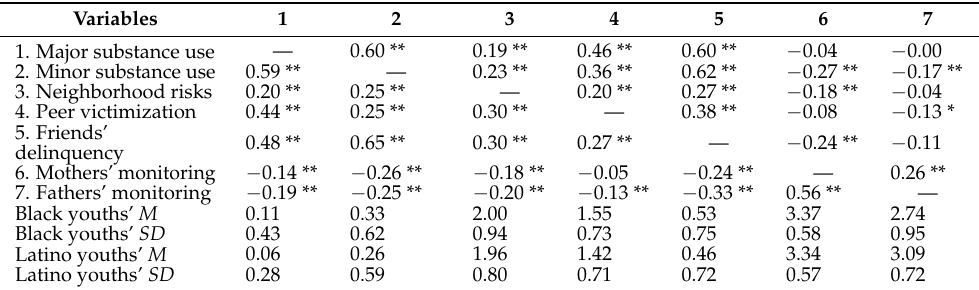
Table 3. Means, standard deviations, and bivariate correlations for Blacks (above the diagonal) and Latinos (below the diagonal).